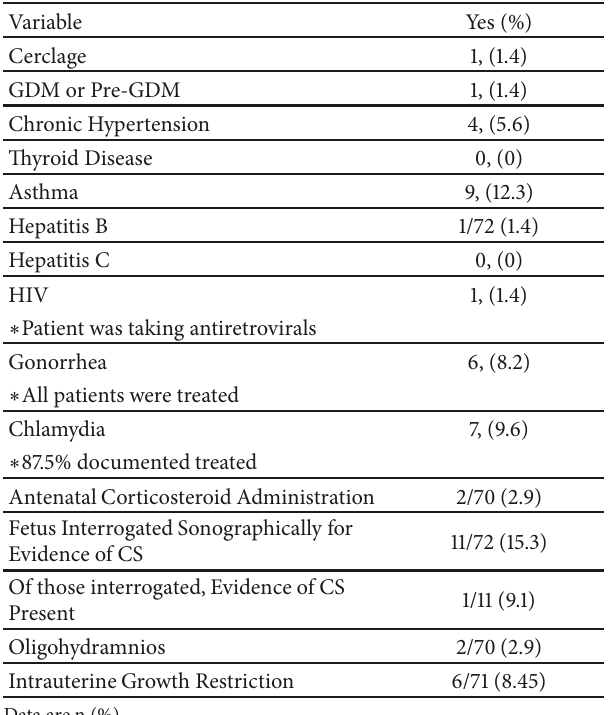
Table 2: Antepartum variables: N = 73 unless otherwise specified.